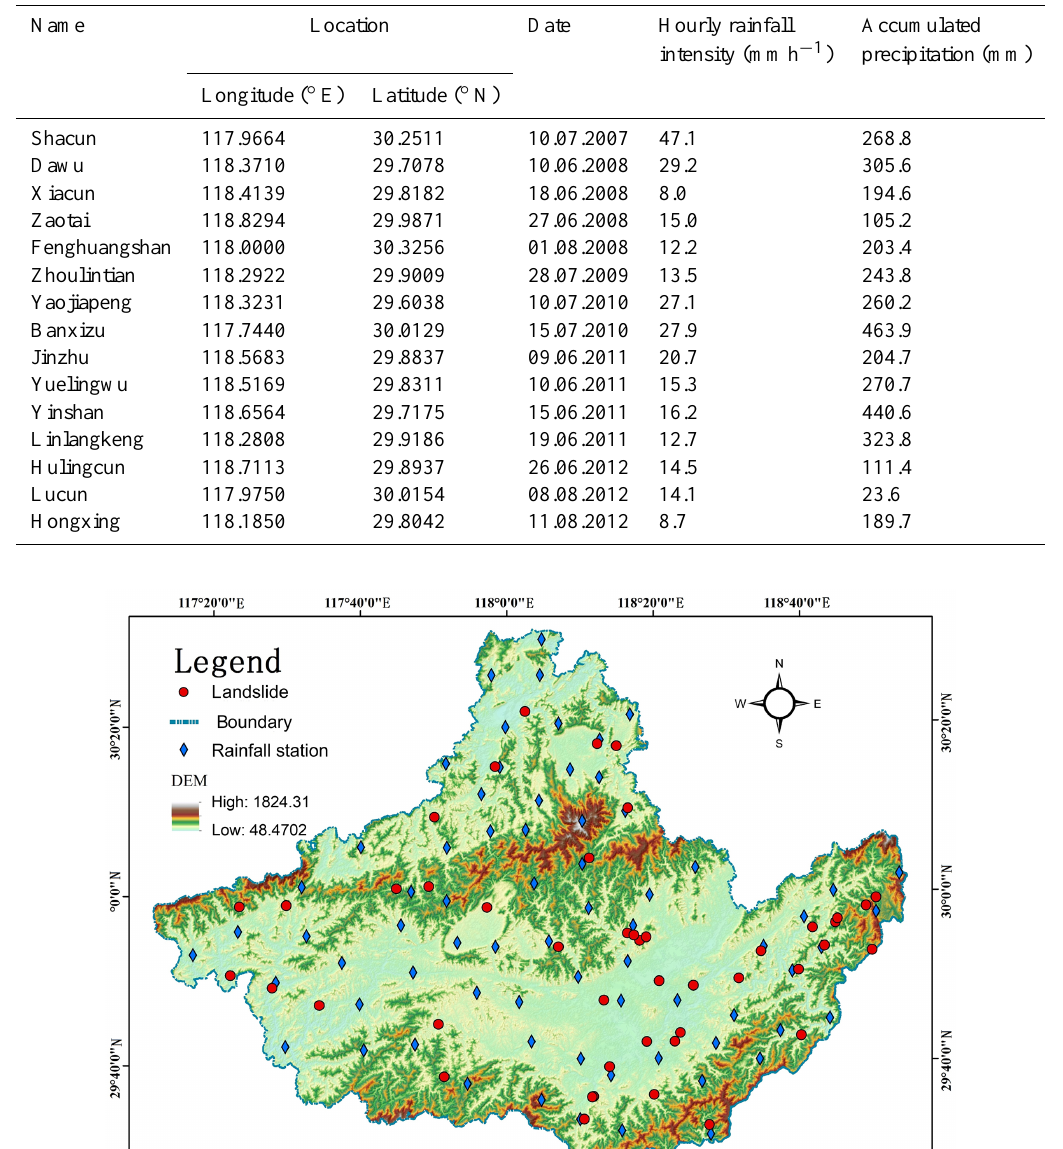
Table 1. Typical shallow landslides triggered by rainfall in the Huangshan region.